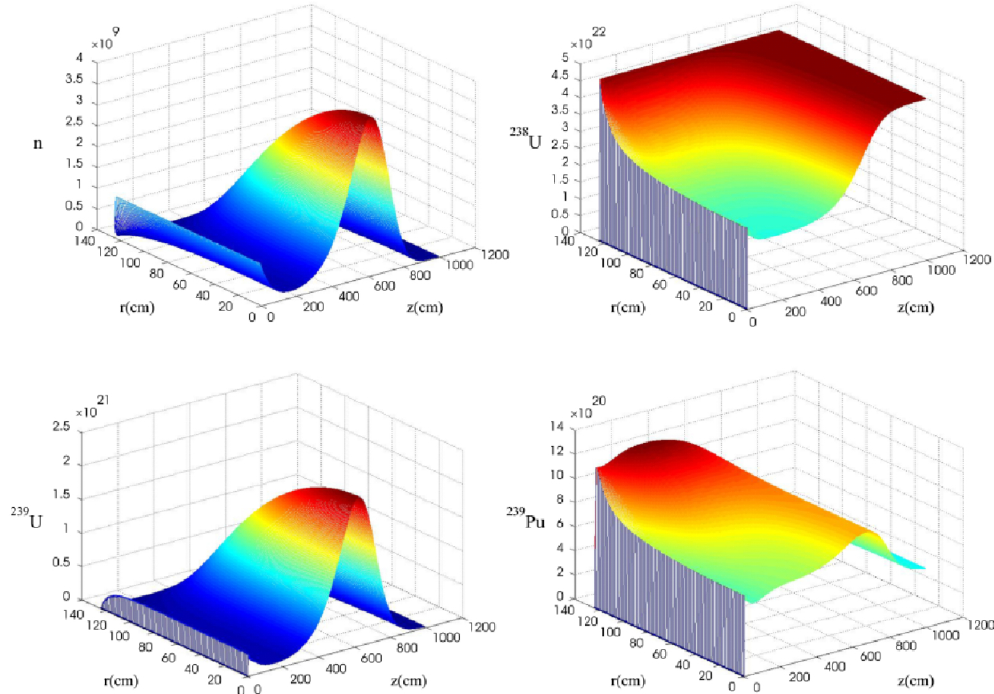
Figure 5. Concentration kinetics of neutrons, 238 U , 239 U and 239 P u in the cylindrical reactor core with radius of 125 cm and 1000 cm long over the time 240 days. Here r is transverse spatial coordinate axis (cylinder radius), z is longitudinal spatial coordinate axis (cylinder length).